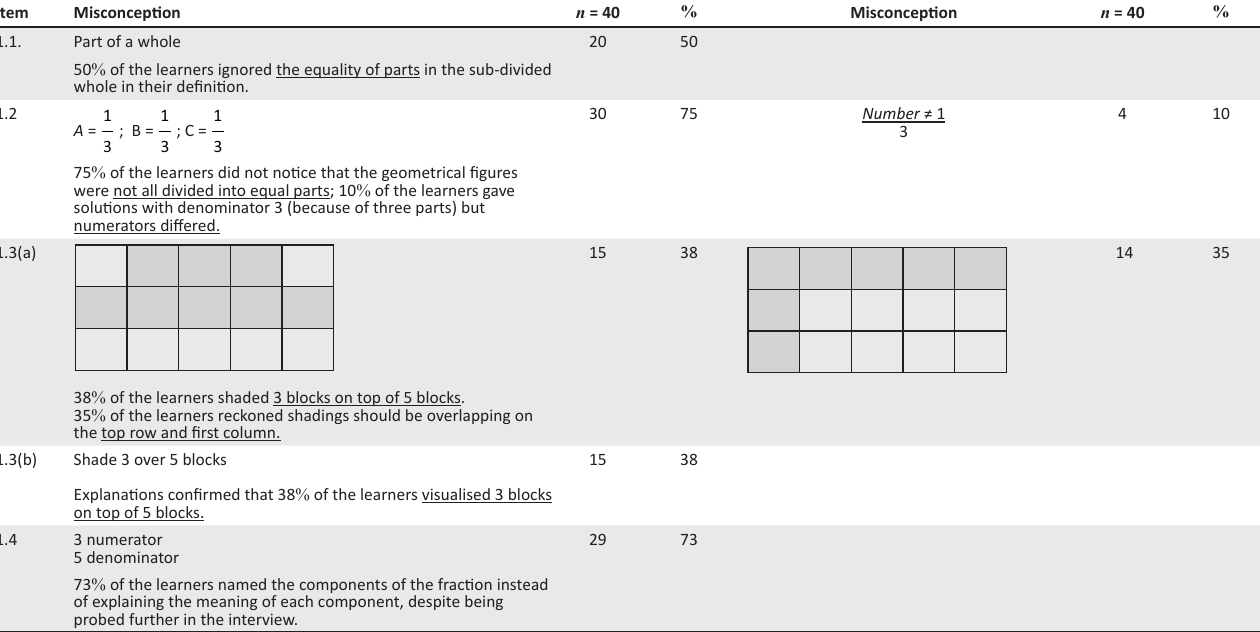
TABLE 3: Most common misconceptions and faulty understanding in items 1.1 to 1.4.